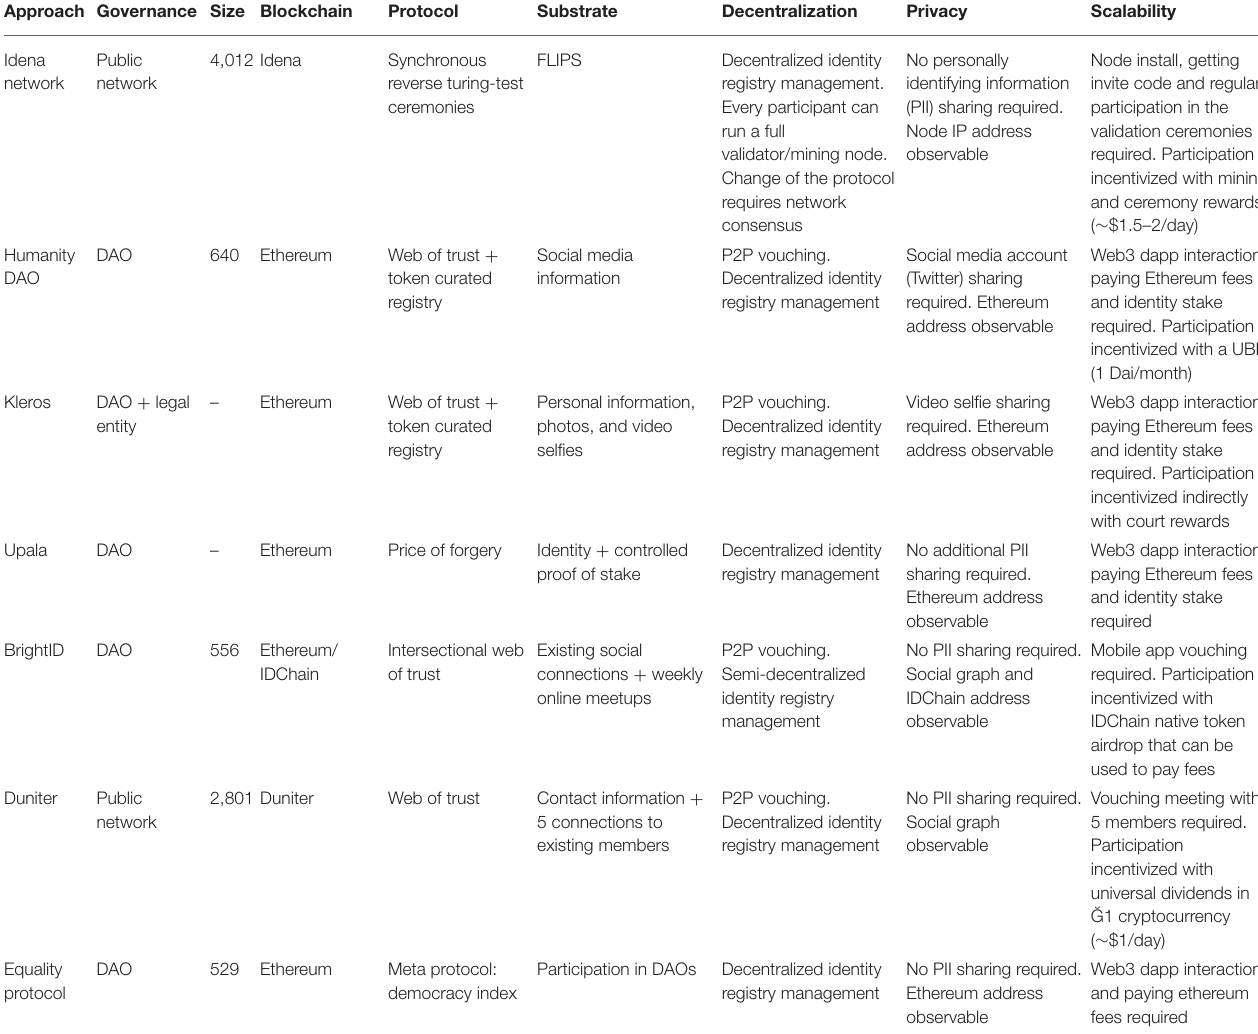
TABLE 1 | Summary of Approach Properties and